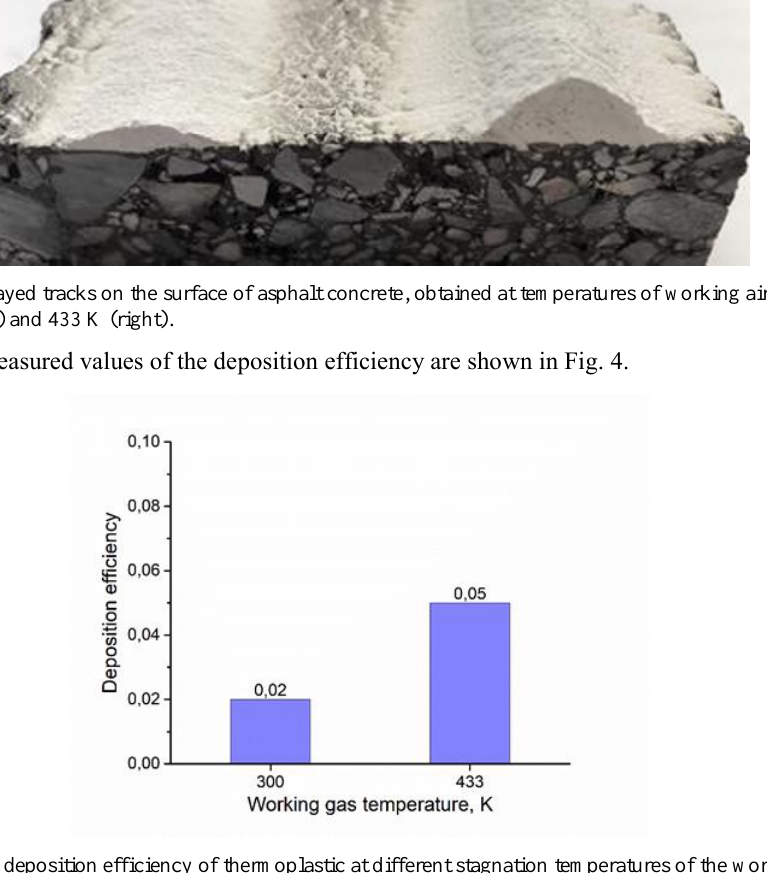
Fig. 4. The deposition efficiency of thermoplastic at different stagnation temperatures of the working